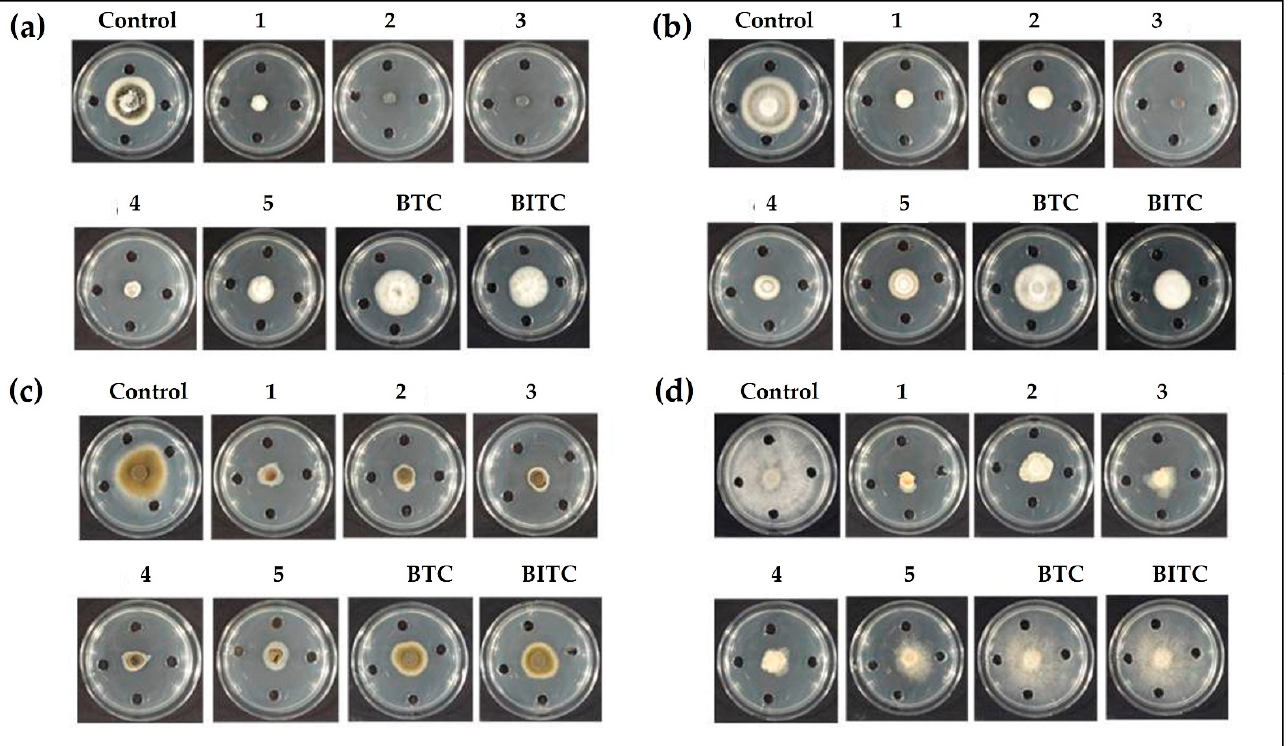
Figure 4. Impact of selenocyanates and thiocyanates on the growth of ( a ) V. dahliae , ( b ) V. longisporum , ( c ) A. brassicicola and ( d ) B. cinerea. ( c ) A. brassicicola and ( d ) B. cinerea